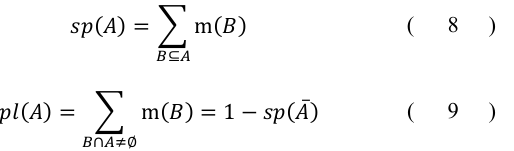
Table 1 shows all subsets of 2 (cid:2944) and their probability masses. The justification for the assignment of the belief functions for